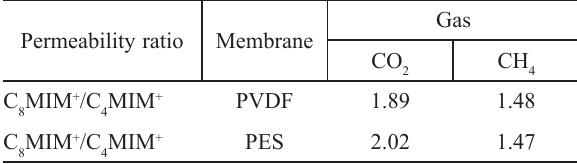
Table 7 – Permeability ratios for the pair C with the respective membranes PVDF and PES